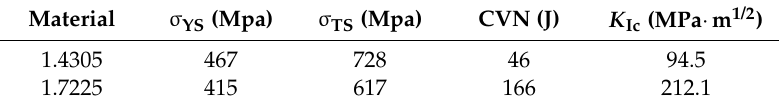
Table 2. Yield strength ( σ YS ) and tensile strength ( σ TS ) of the considered materials [16,17].